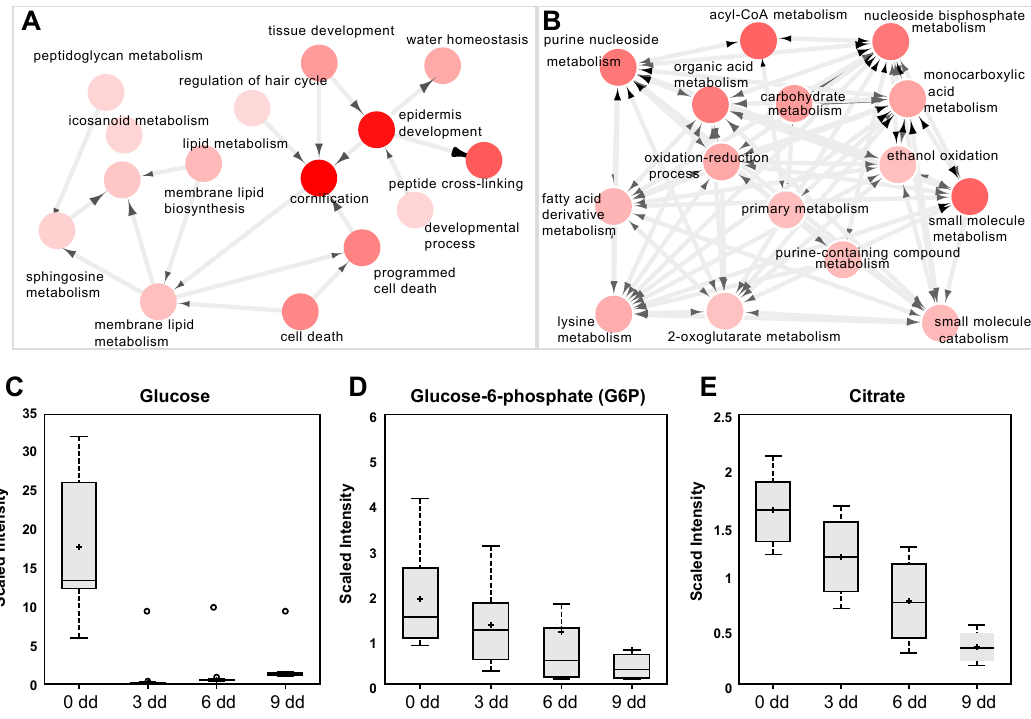
Figure 3. ( A ) Clustering and annotation analysis (methods) from RNAseq experiment in differentiated keratinocytes. The nodes are the processes where most regulated gene cluster, the arrows represent the connections between the processes. As is visible, there is a preponderant association with epidermis differentiation, cornification, and peptide crosslinking. ( B ) The same analysis showed another cluster (of downregulated genes) acknowledging downregulation of energy pathway metabolism. ( C – E ) Analysis of metabolic intermediate of glycolysis and Krebs cycle in differentiating keratinocytes, showing depression of G6P and citrate. In this case (first panel), a strong decrease of cellular content of glucose is visible.